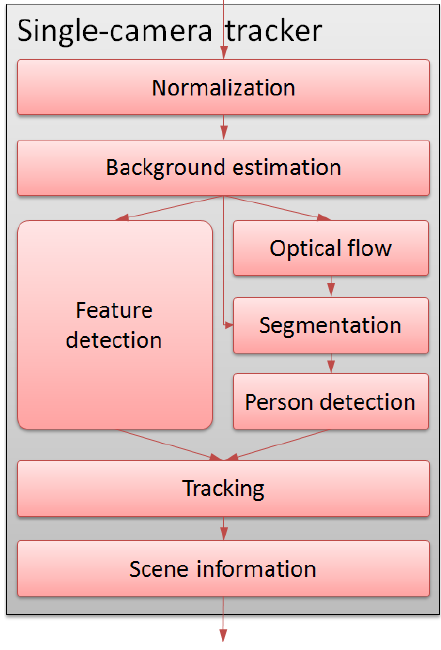
Figure 2: Design of our single-camera